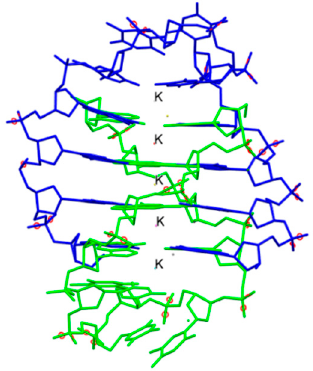
Figure 1. The crystal structure of the bimolecular quadruplex formed by the Oxytricha nova telomeric sequence d(G 4 T 4 G 4 ). Potassium ions are shown with label K. Hydrogen atoms are omitted for clarity. PDB code: 1JPQ. Ref. [9] .